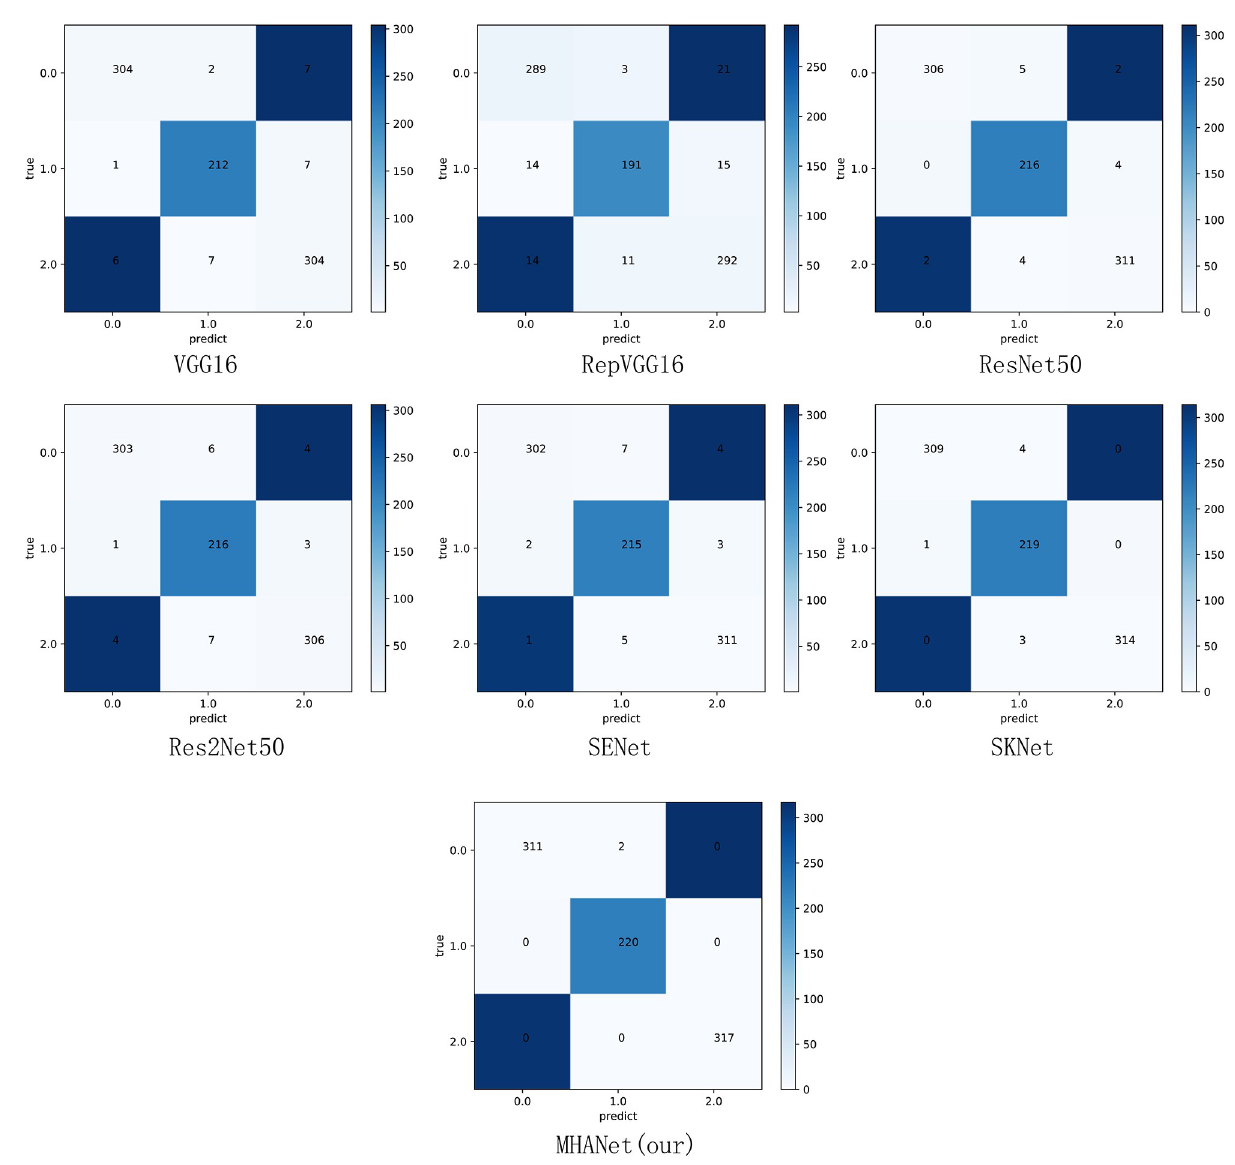
Fig 3. Confusion matrix of the